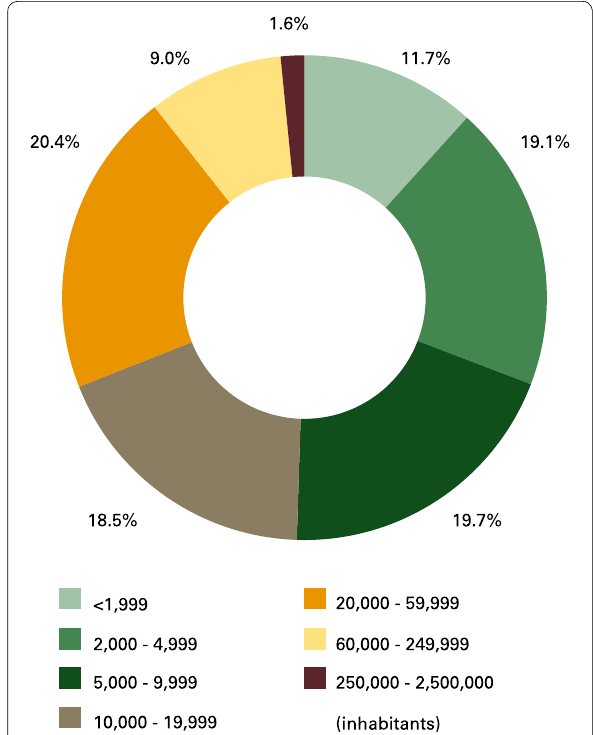
Fig. 3 Distribution of one- and two-interior buildings built between 1961 and 1991 by size of the Municipality where they are located (authors’ calculations on data from Istat